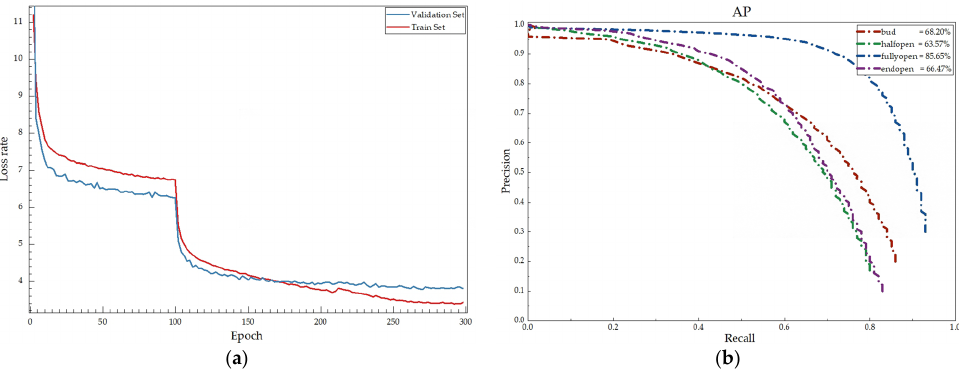
Figure 5. Loss and P–R curve. ( a ) Loss curve of S-YOLO-s. ( b ) P–R curves with mixed datasets (IoU = 0.3).